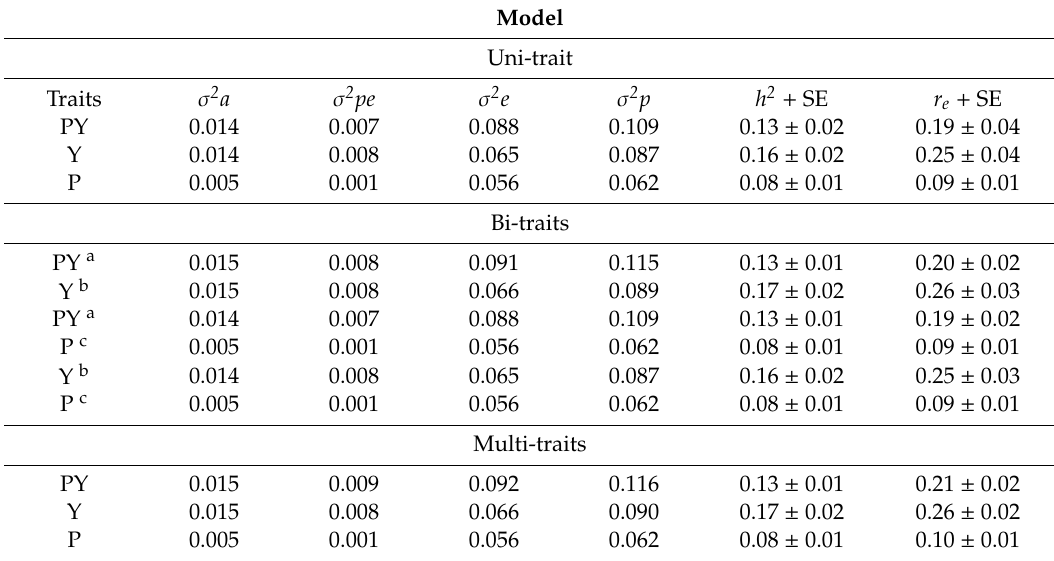
Table 2. Estimates of variance components (additive genetic ( σ 2 a ), permanent environmental ( σ 2 pe ), traits estimated by uni-, bi- and multi-traits models in Murciano-Granadina